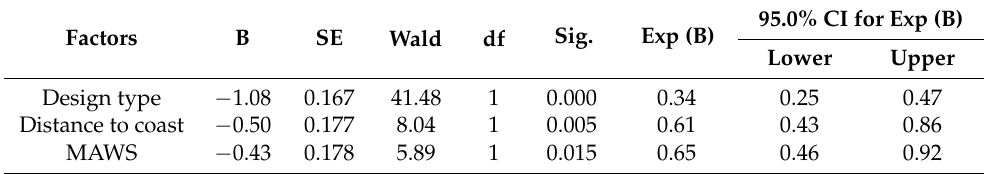
Figure 6. Kaplan–Meier survival functions of switches based on the operational, climatic and geographic factors. ( a ) Design type ( b ) Climatic regions ( c ) Distance to coast ( d ) Turbine age ( e ) Elevational location ( f ) MAWS ( g ) NOPF. Table 10. Cox regression results for